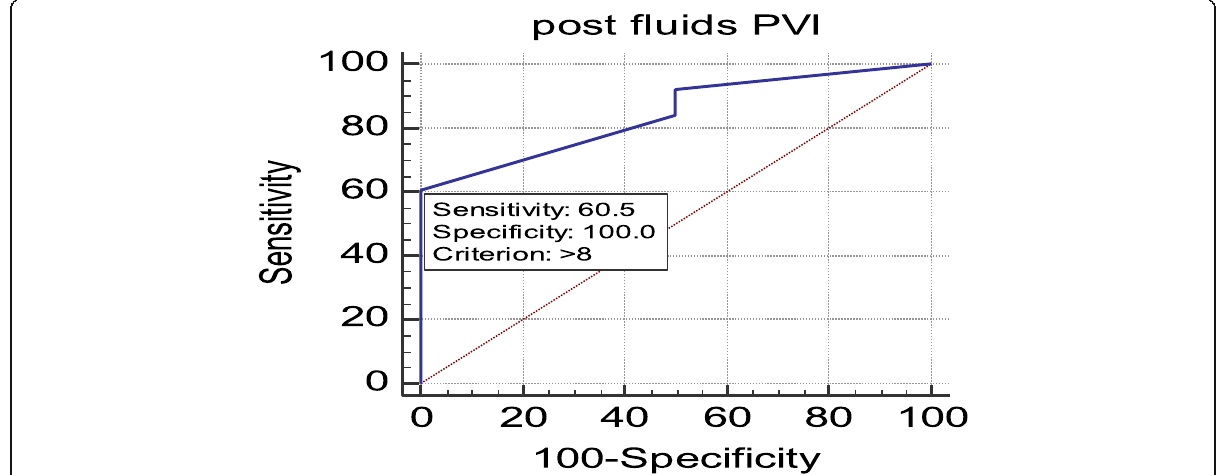
Fig. 4 Receiver operating characteristic (ROC) analysis of PVI after fluid bolus. Pleth Variability Index (PVI) is a predictor of fluid response after 5 ml/ kg bolus during periods of hypovolemia with 60.5% sensitivity and 100% specificity